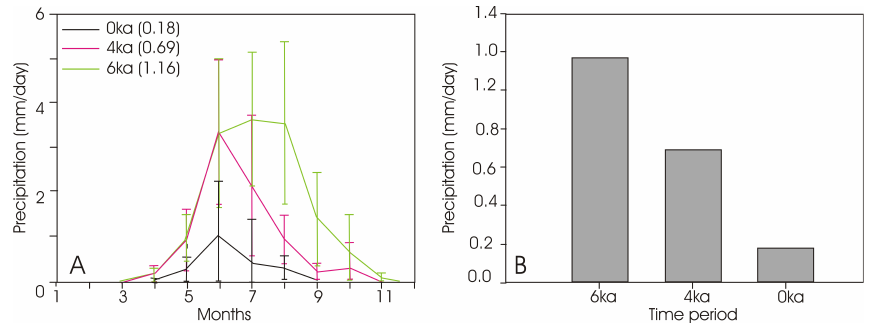
Fig. 4. Precipitation (mmday − 1 ) over Lake Yoa region (17.5–22.5 ◦ E, 17–22 ◦ N) simulated for 6ka, 4ka and 0ka. (A) Monthly mean seasonal cycle. The error bars represent the standard deviation representing interannual variability and are estimated using 41 year of simulated data. (B) Annual